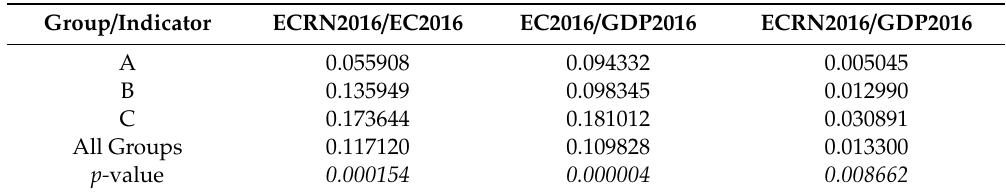
Table 12. Group averages for IREN in 2016.